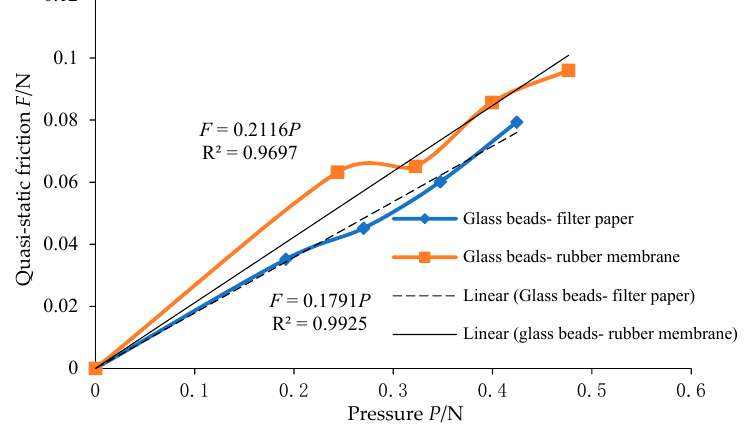
Figure 6. Sliding friction - pressure curve.